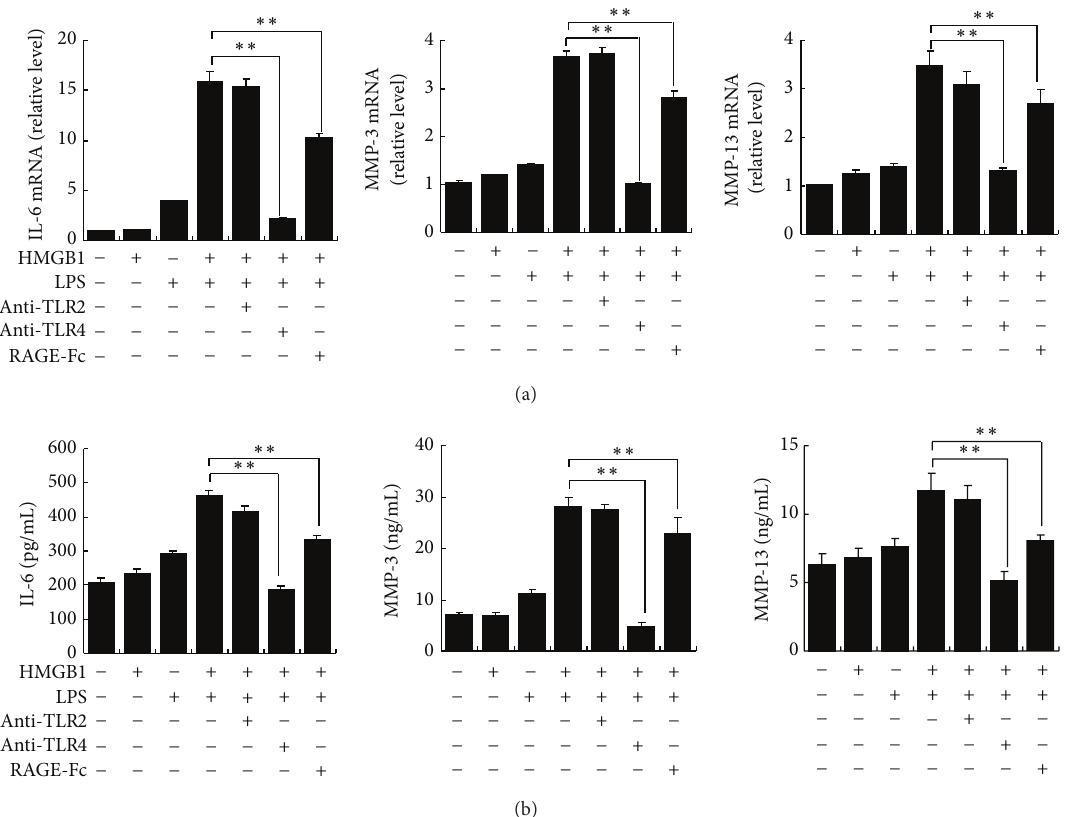
Figure 4: Synergistic effects of HMGB1-LPS were inhibited by blockers of TLR4 and RAGE. Cultured SF were pretreated with anti-TLR2 (10 𝜇 g/mL), anti-TLR4 (10 𝜇 g/mL), or RAGE-Fc (10 𝜇 g/mL) for 30 min and then incubated with 10ng/mL of LPS and/or 100 ng/mL of HMGB1 for 3 h (a) or 48 h (b). (a) mRNA expression levels of IL-6, MMP3, and MMP-13 were analyzed by quantitative real-time RT-PCR. (b) The concentrations of IL-6, MMP-3, and MMP-13 proteins in culture supernatants were measured by ELISA. Data are expressed as mean ± SD ( 𝑛 = 4 ). ∗∗ 𝑃 < 0.01 compared with SF stimulated with HMGB1 plus